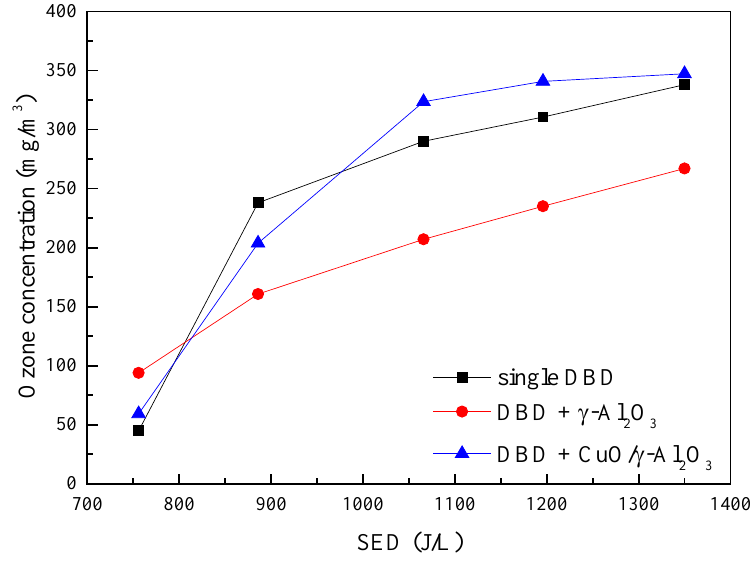
Figure 7. Effect of SED on the concentration of O 3 in the single DBD reactor and the combined plasma catalysis reactor.